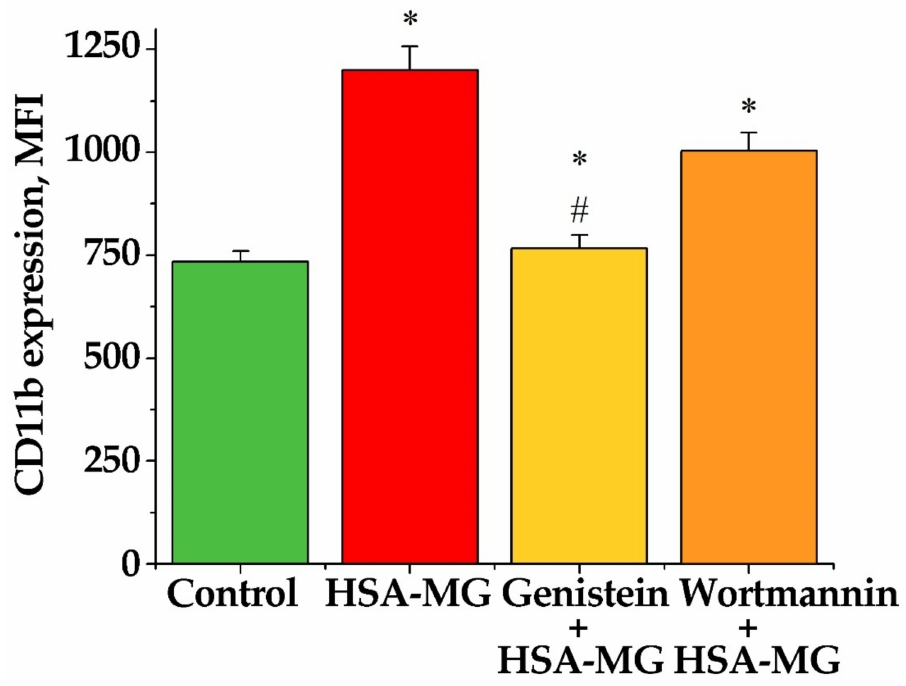
Figure 9. Effect of genistein (100 µ M) and wortmannin (100 nM) on expression of CD11b on neutrophil surface in response to HSA-MG (0.5 mg/mL). Results are expressed in mean fluorescence intensity (MFI) ± SEM of at least three independent experiments. * p < 0.05 compared to control, # p < 0.05 compared to HSA-MG